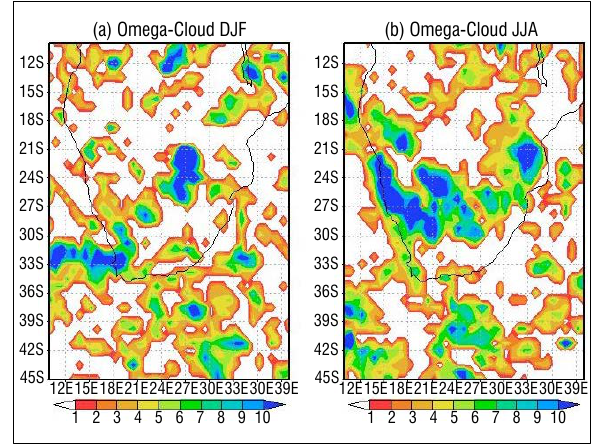
Figure 10: Granger causality of omega to cloud cover in (a) December– February (DJF) and (b) June–August (JJA).